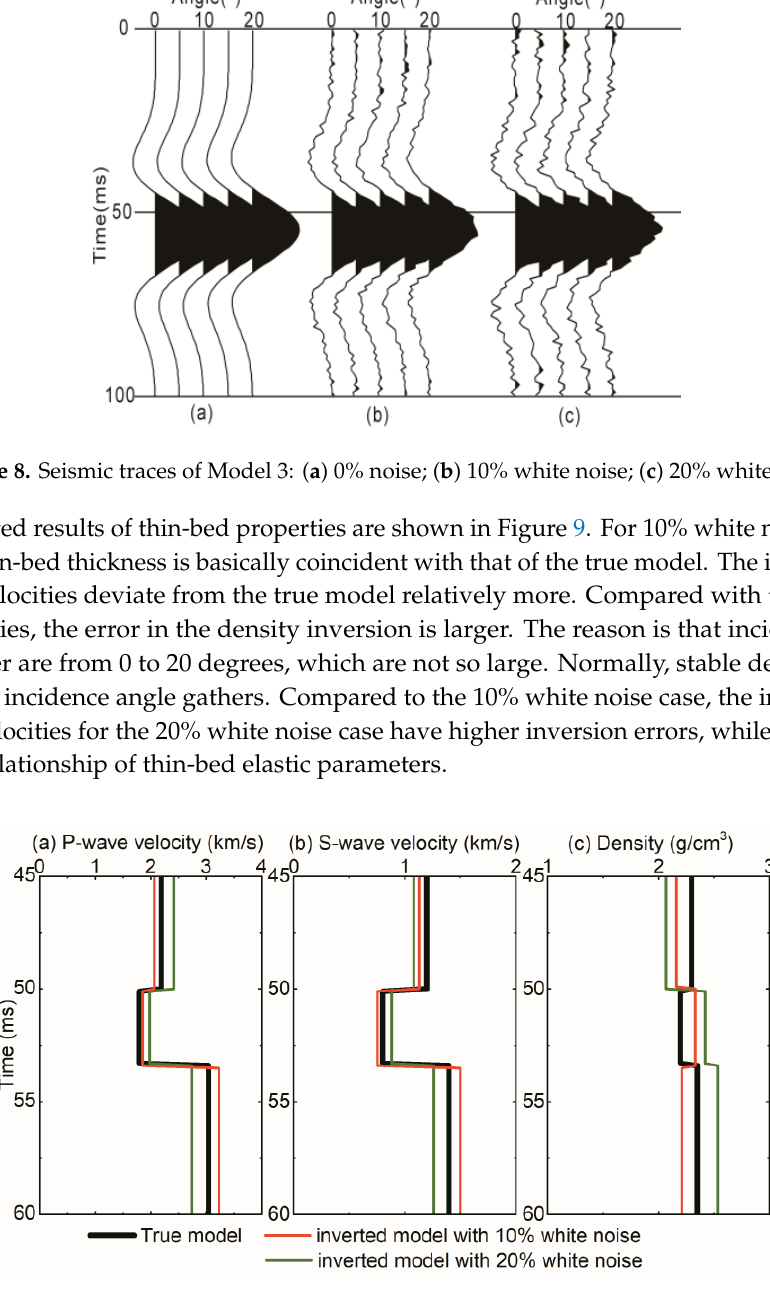
Figure 7. Inversion results of Model 3 by the linear analytic approximation and Zoeppritz equations: